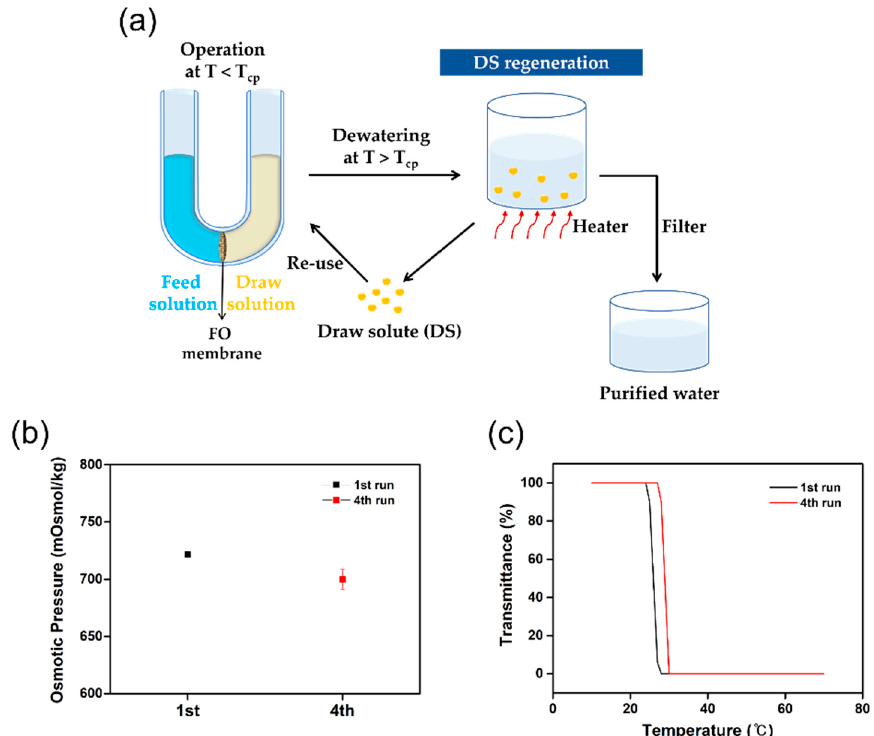
Figure 9. Recyclability study of [TBP][DMBS] in four cycles: ( a ) scheme of the FO system, ( b ) osmotic pressures, and ( c ) thermoresponsive behavior tests. From the 2nd to the 4th run, the recovered [TBP][DMBS] from the previous run was used.